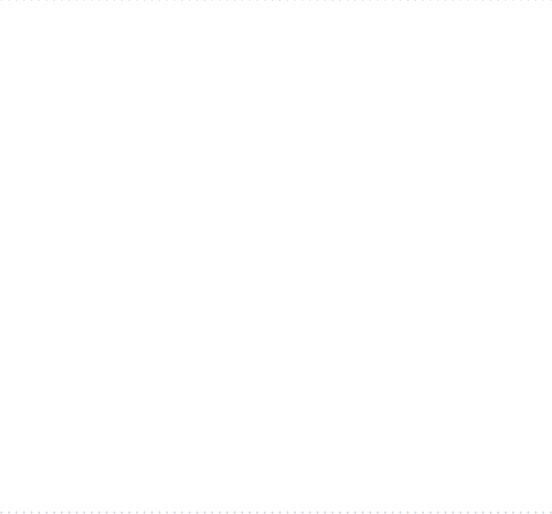
Figure 1. Latent variable predicted relative weight for each sample.